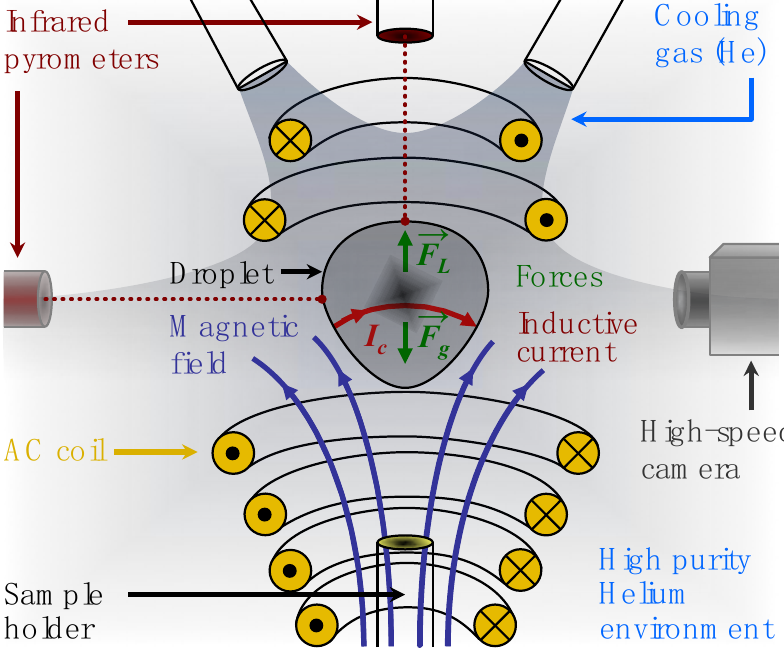
Figure 16. Schematics of electromagnetic levitation; the droplet is placed in a levitation coil consisting of four water cooled windings and two counter windings at the top to stabilize the position of the levitated drop. Two infrared pyrometers measure contactless the temperature of the droplet from the top and from a radial side. A high-speed camera is used to observe the rapid propagation of the solidification front. Cooling gas from the top is necessary to remove the heat from the sample to be cooled and undercooled. This is achieved by a high thermal conductivity gas like He. The arrows give the geometry of the magnetic field inside the coil. F and F denote the levitation force and the gravitational L g force while I is the current induced in the droplet by the alternating electromagnetic c